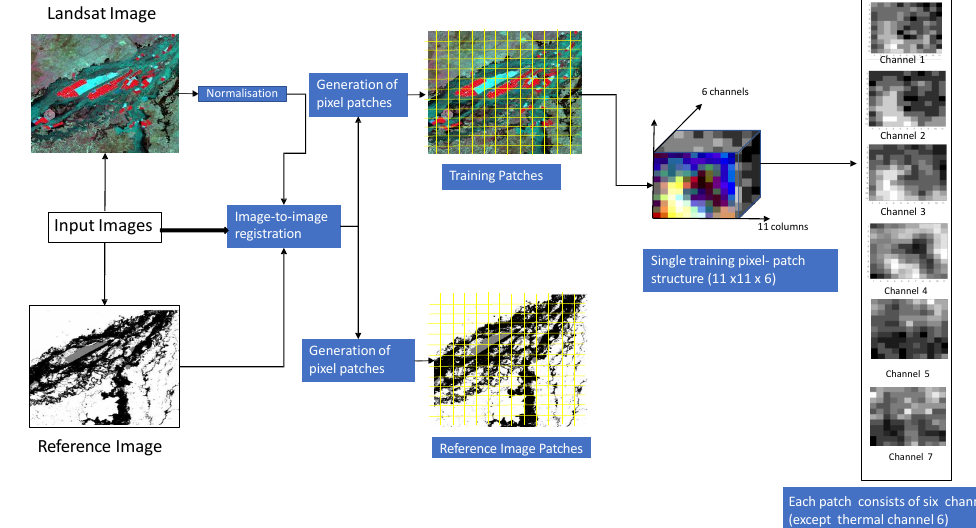
Figure 4. The workflow for the generation of a training sample. Geometric correction and data normalisation is followed by generation of training sample patches. For training samples with neighbourhood size 11 × 11 (N-11), each training sample consists of 11 rows, 11 columns and six channels or bands (Channel 1, 2 and 3 represents red, green and blue; channel 4 represents near-infra red, channel 5 represents middle-infrared and channel 6 represents short-wave